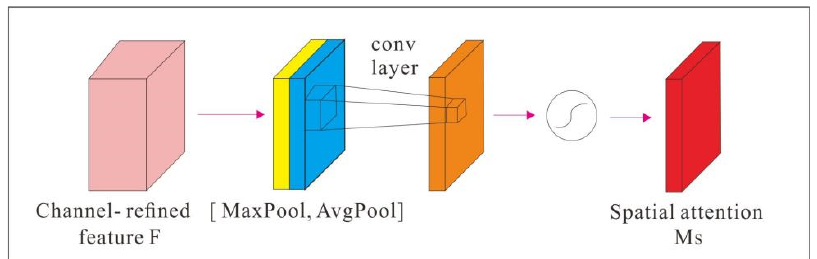
Figure 11. Spatial attention module.